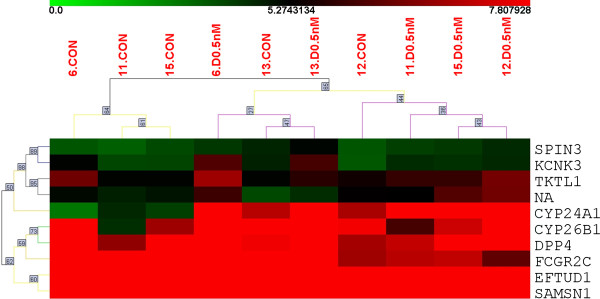
Unsupervised hierarchical clustering of breast cancer slices exposed to vehicle or 0.5nM 1,25(OH)2D3. Five tumor samples (6, 11, 12, 13, 15) were cultured with or without 0.5nM 1,25(OH)2D3 for 24 h. Gene expression was evaluated by microarray and analysis performed using SAM paired analysis (FDR ≤ 0.1). The upper colored bar and values indicate gene expression in target samples (i.e., red, more expressed and green, less expressed). Colored lines of the dendrogram and numbers stand for the support for each clustering, black and gray, more reliable; yellow and red, less reliable. Nine genes were differentially expressed (plus one probe without a gene name, NA). Two branches are identified, one of them including three control samples.